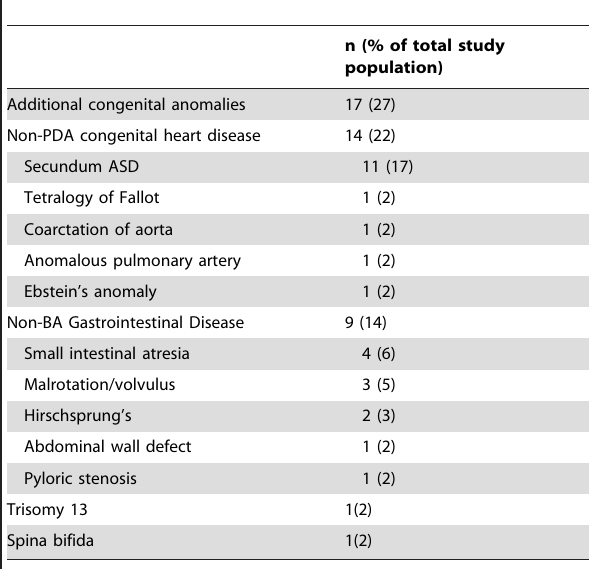
Table 2. Occurrence of additional congenital anomalies among the 64 biliary atresia